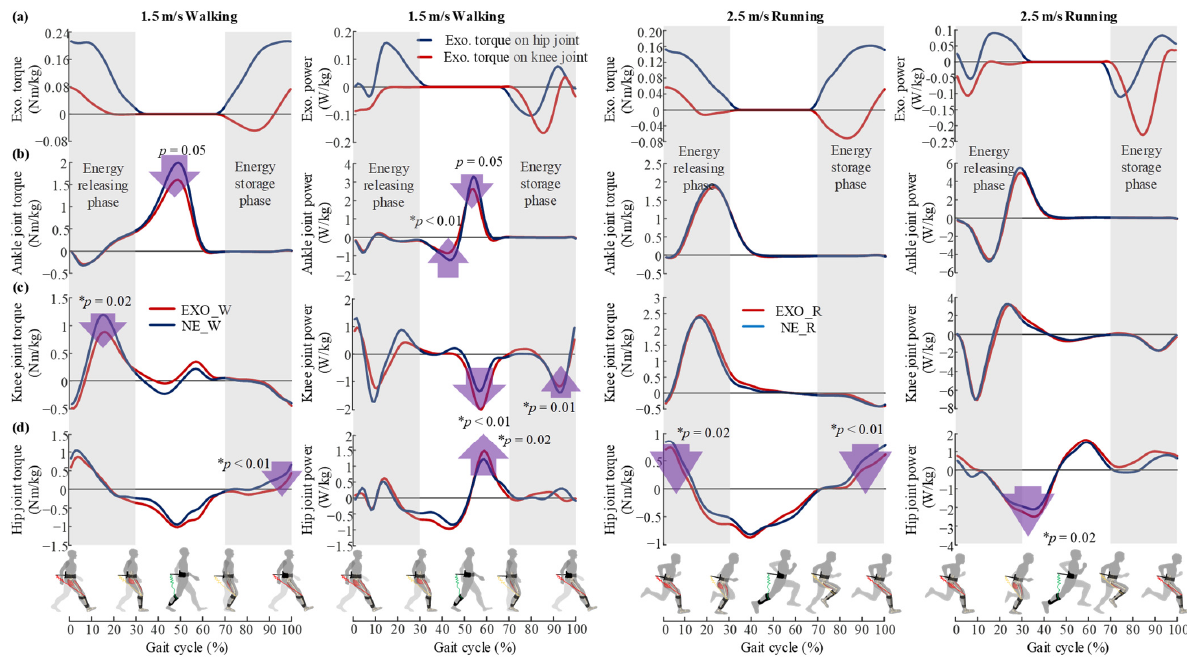
Figure 7. Exoskeleton mechanics and biological joint kinetics. ( a ) Exoskeleton torque and power on hip and knee joints in walking and running conditions. ( b – d ) Biological joint torque and power in walking and running conditions. The p values were the statistical comparison result of peak torque/power between NE (walking/running without exoskeleton) and EXO (walking/running with exoskeleton) conditions. The asterisk (*) indicates the statistical difference in peak joint torque and peak joint power between the tested conditions during walking and running using two-sided paired t-test.